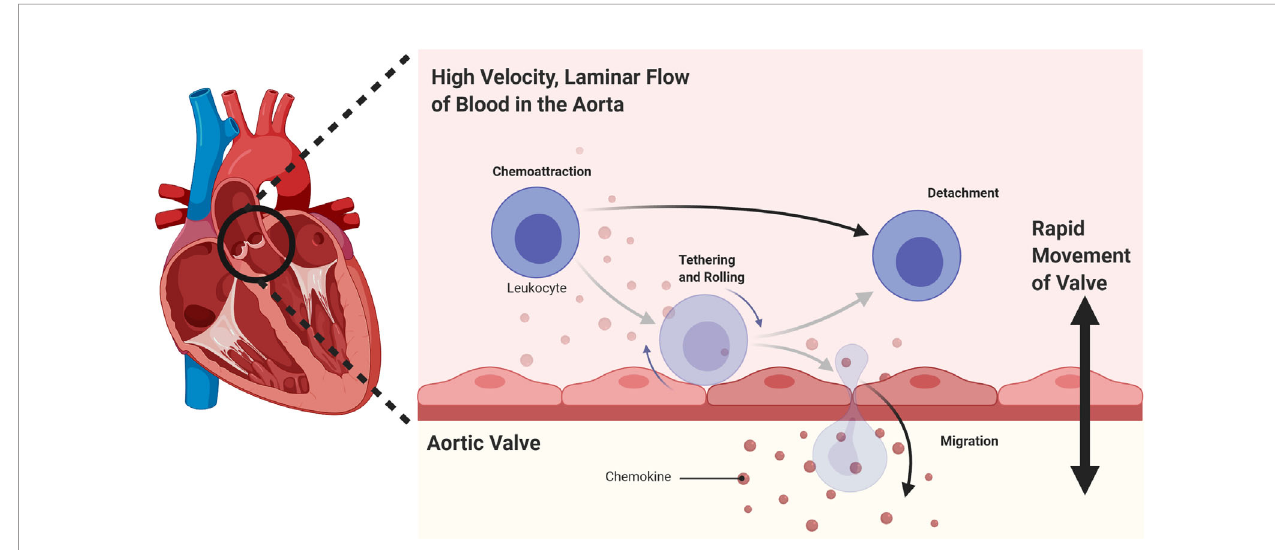
FIGURE 3 | A possible mechanism for the immune privilege of heart valves could be inhibition of immune cell extravasation in the context of rapid blood fl ow in the aorta, combined with the vigorous movement of the opening and closing valve lea fl